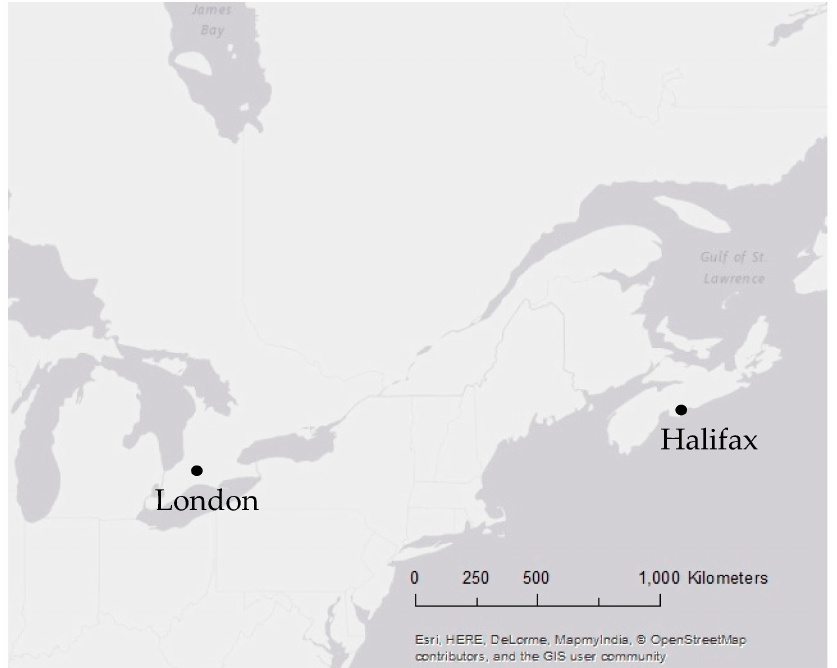
Figure A1. Halifax, Nova Scotia is located in Atlantic Canada and London, Ontario is located in Central Canada.